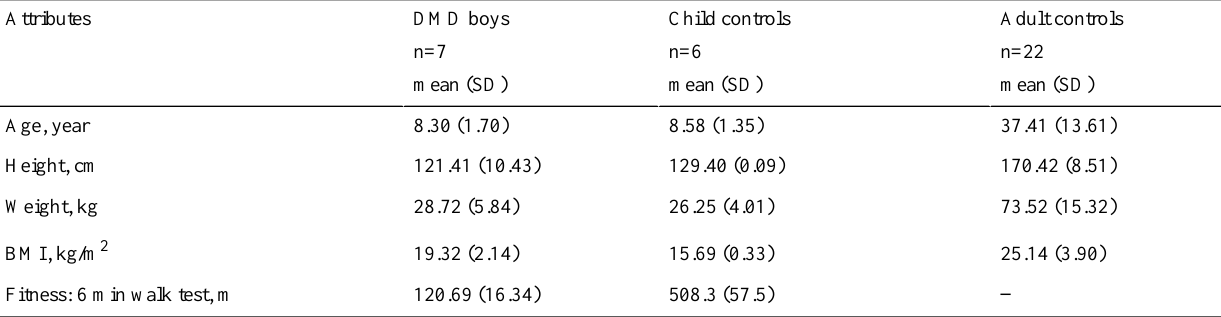
Table 1. Characteristics of subjects in the study.